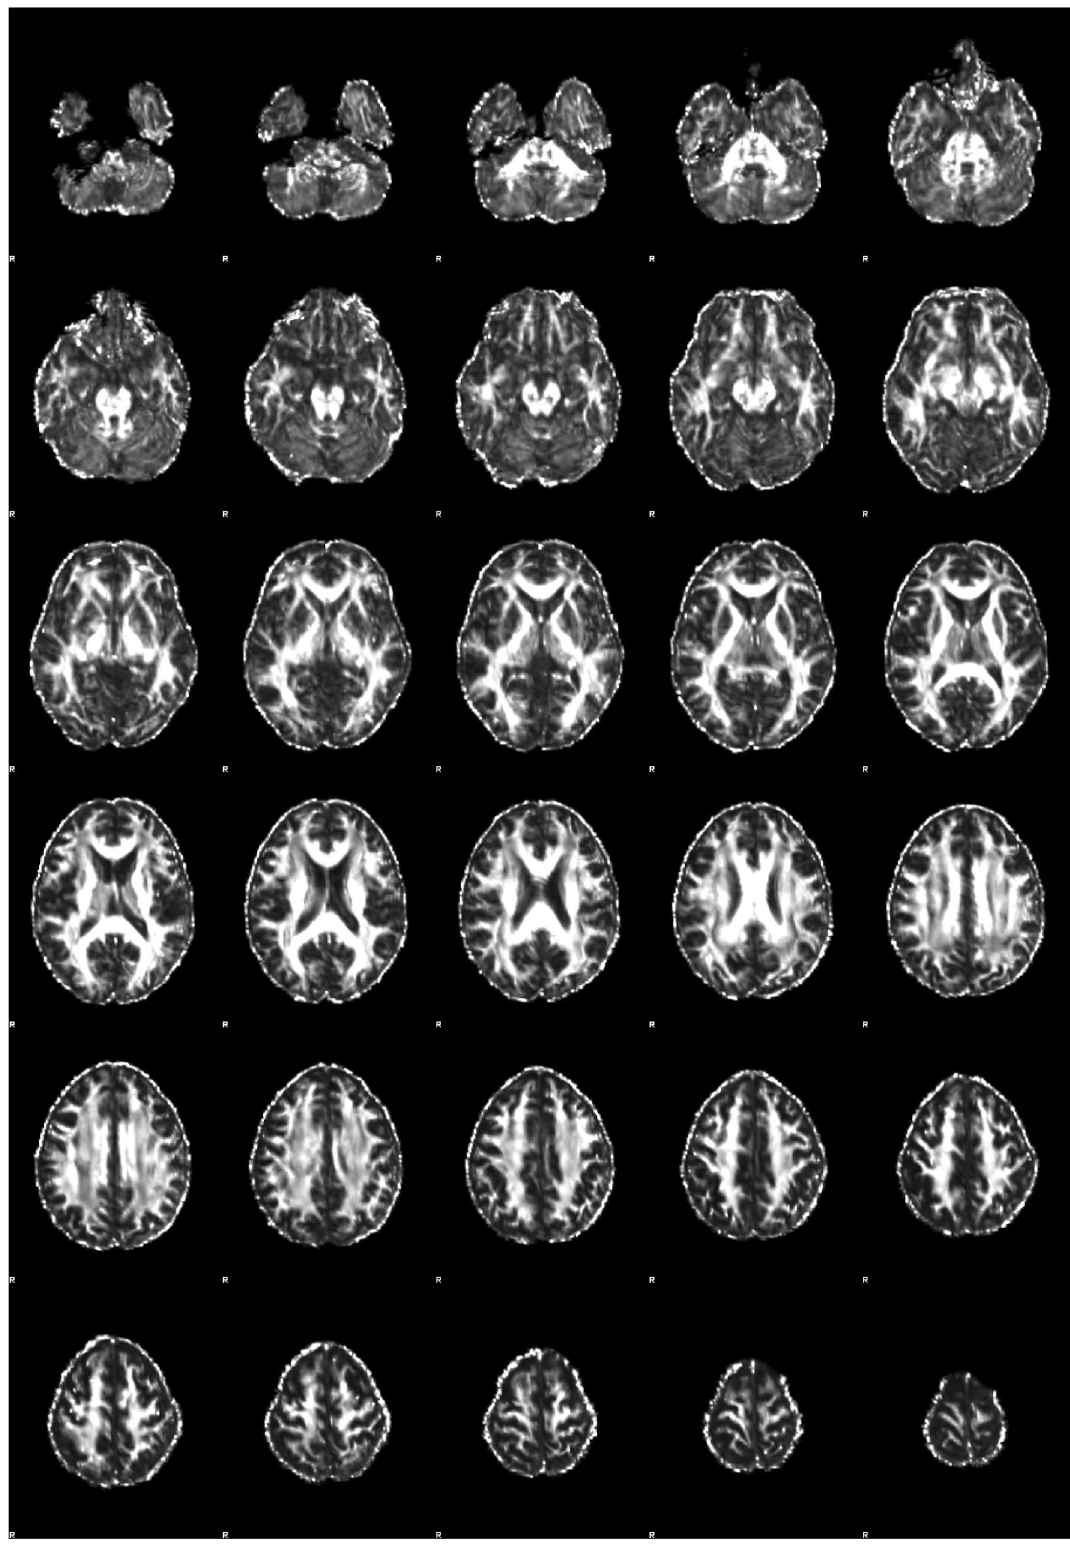
Figure 7. MRI slices of subjects with the smallest